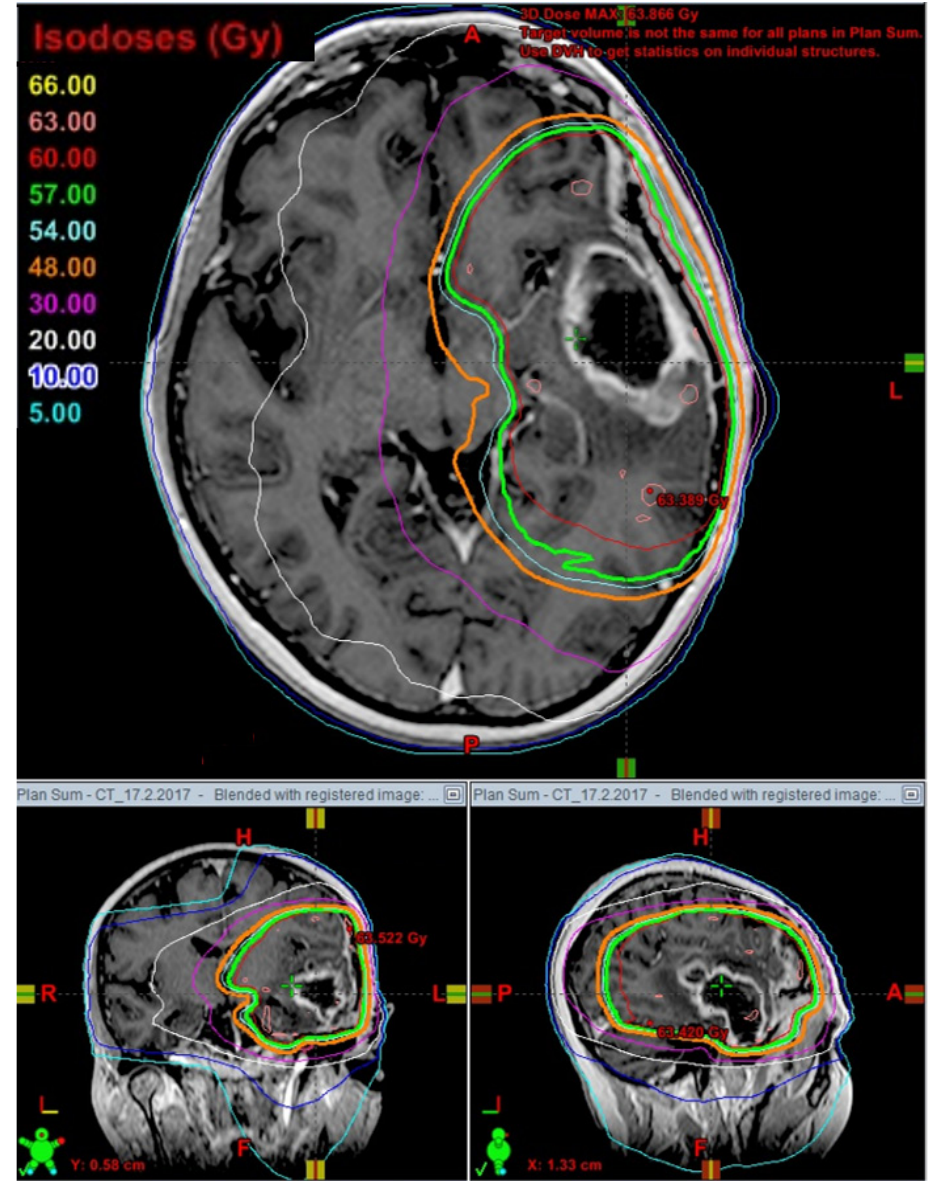
Fig. 3. Isodoses from original radiotherapy treatment plan of selected representative patient. Stronger green line represents 57 Gy (that is 95% isodose, encompassing planning target volume) and stronger orange line represents 48 Gy (that is 80%